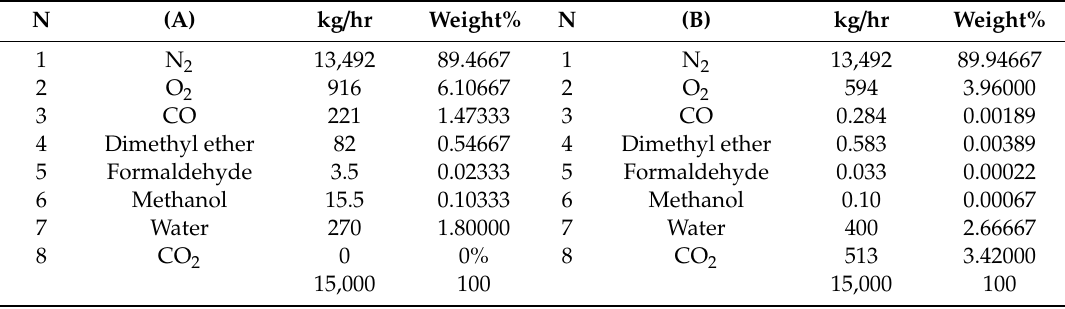
Table 1. The composition of waste o ff -gases ( A ) before the purification process and ( B ) after the catalytic process of purification.